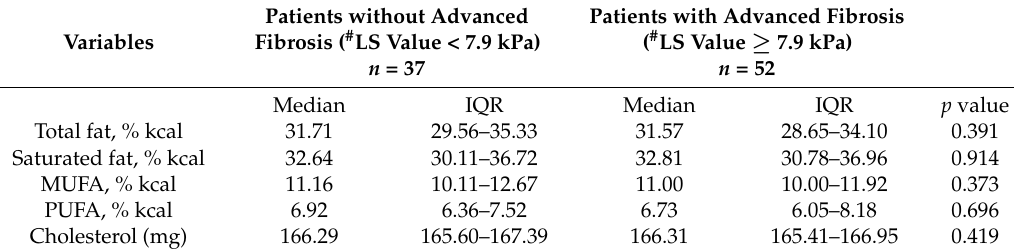
Table 4. Dietary intake of patients with and without advanced